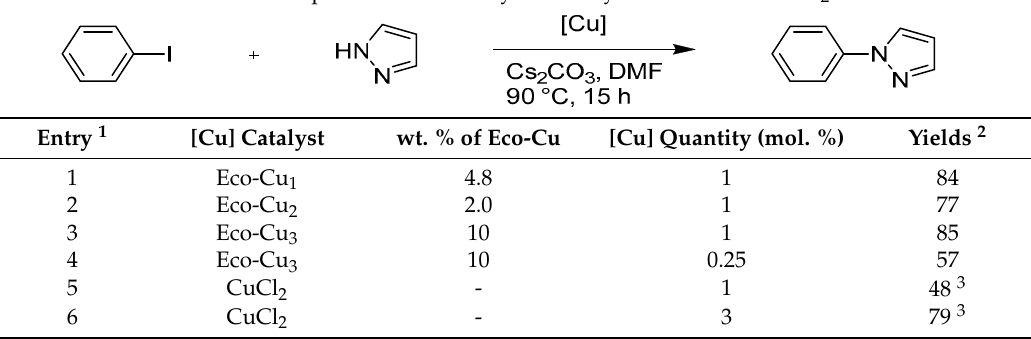
Table 6. A comparison of the catalytic activity of Eco-Cu and CuCl 2 .